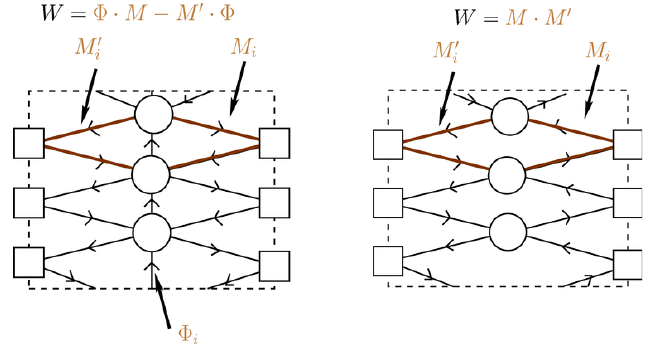
Figure 2 . Gluing two theories together. We have (cid:8)-gluing on the left and S -gluing on the right.